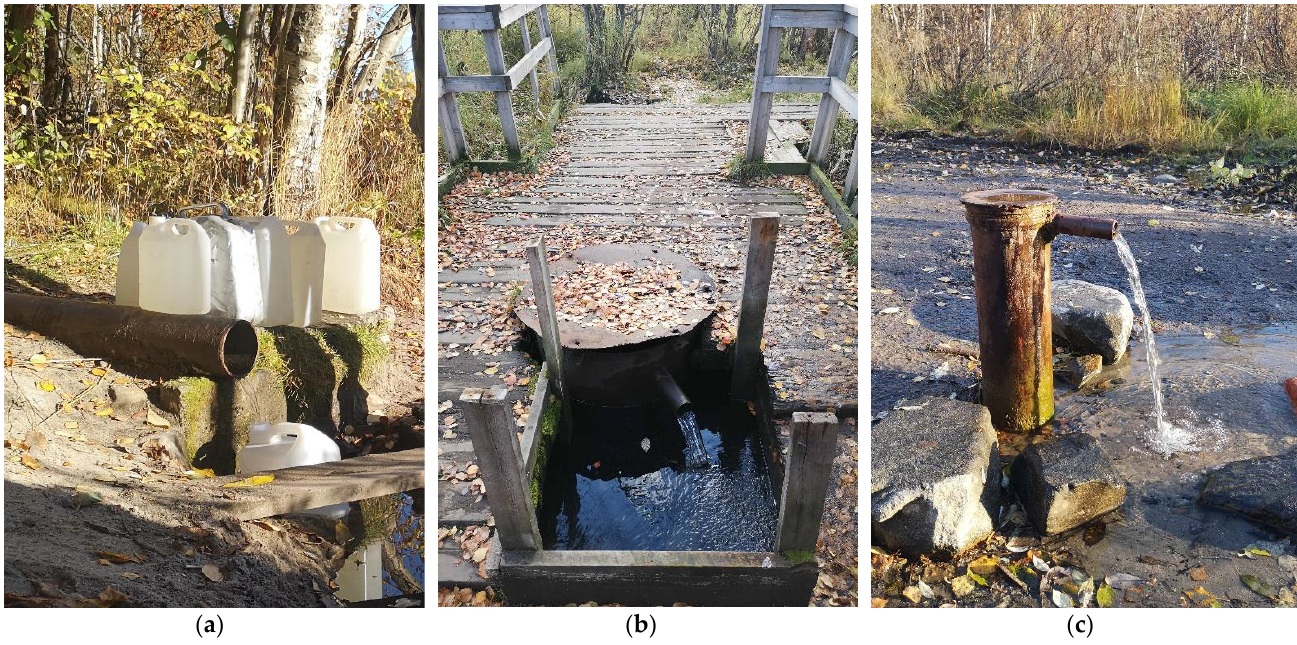
Figure 3. Types of springs: descending ( a ), ascending ( b ) and self-flowing well ( c ).